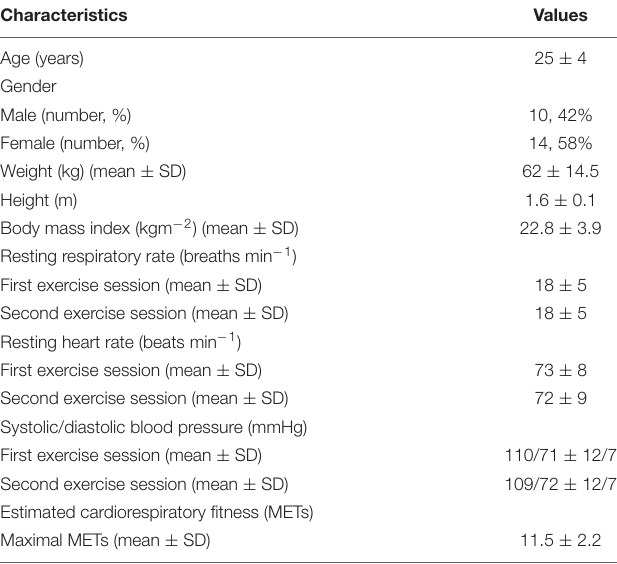
TABLE 1 | Baseline characteristics of the participants.